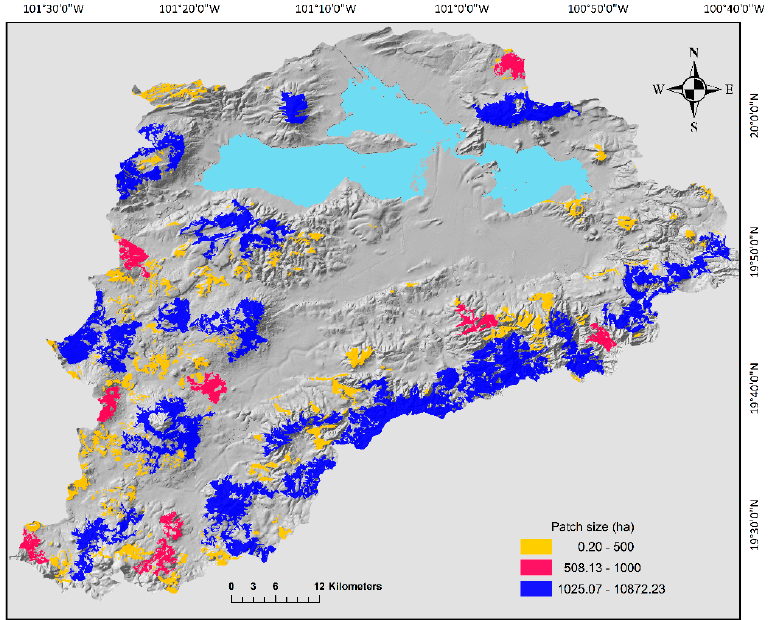
Figure 2. Size (ha) of oak forest fragments in the Cuitzeo Lake Basin. Size categories are shown in the figure.